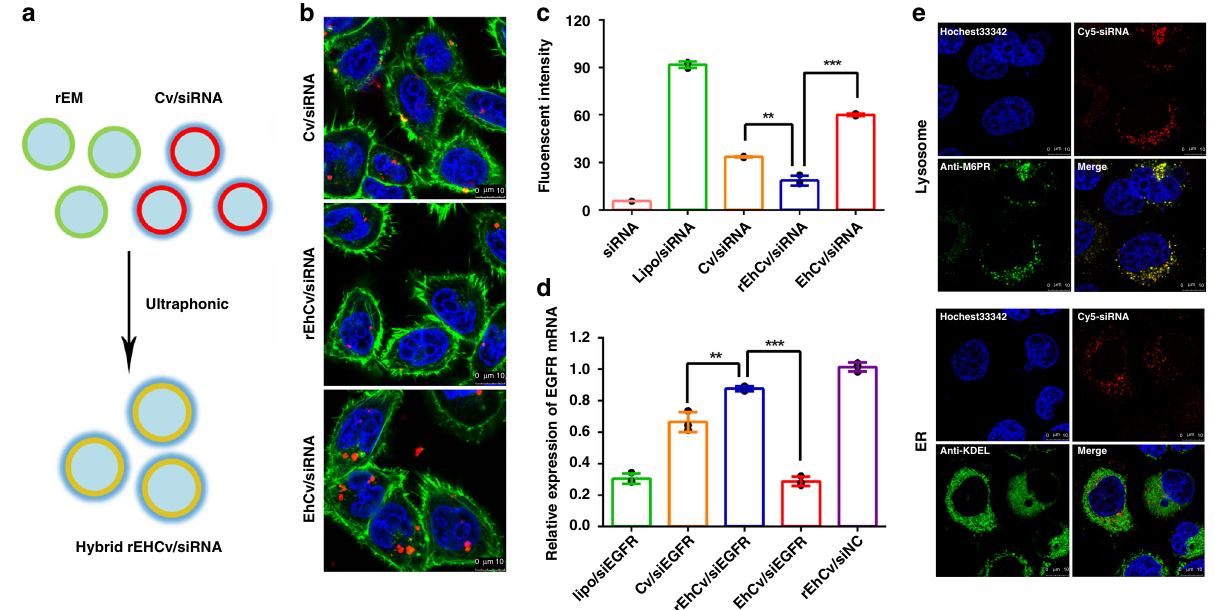
Fig. 4 Functional veri fi cation of protein-removed endoplasmic reticulum (ER) membrane (rEM). a The rEhCv/siRNA NPs was prepared with rEM whose proteins were removed; b Intracellular fl uorescence detected by confocal microscopy; c Intracellular fl uorescence intensities detected by fl ow cytometry; d Relative levels of epidermal growth factor receptor (EGFR) mRNA detected by reverse transcriptase-PCR; e Intracellular fl uorescence colocalization of rEhCv/siRNA NPs in ER and lysosomes, which were stained by Alexa Fluor @ 568-labeled anti-KDEL and anti @ M6PR antibody, respectively. The fi nal concentration of FAM-siNC, Cy5-siNC, and siEGFR were 100 nM. Data are shown as mean ± SD ( n = 3). ** p < 0.01, *** p < 0.001, t